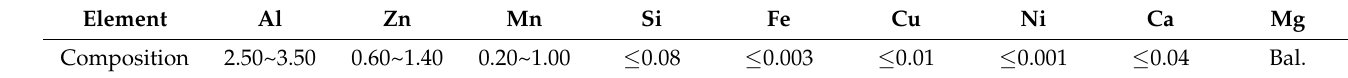
Table 1. The compositions of the main alloying elements of